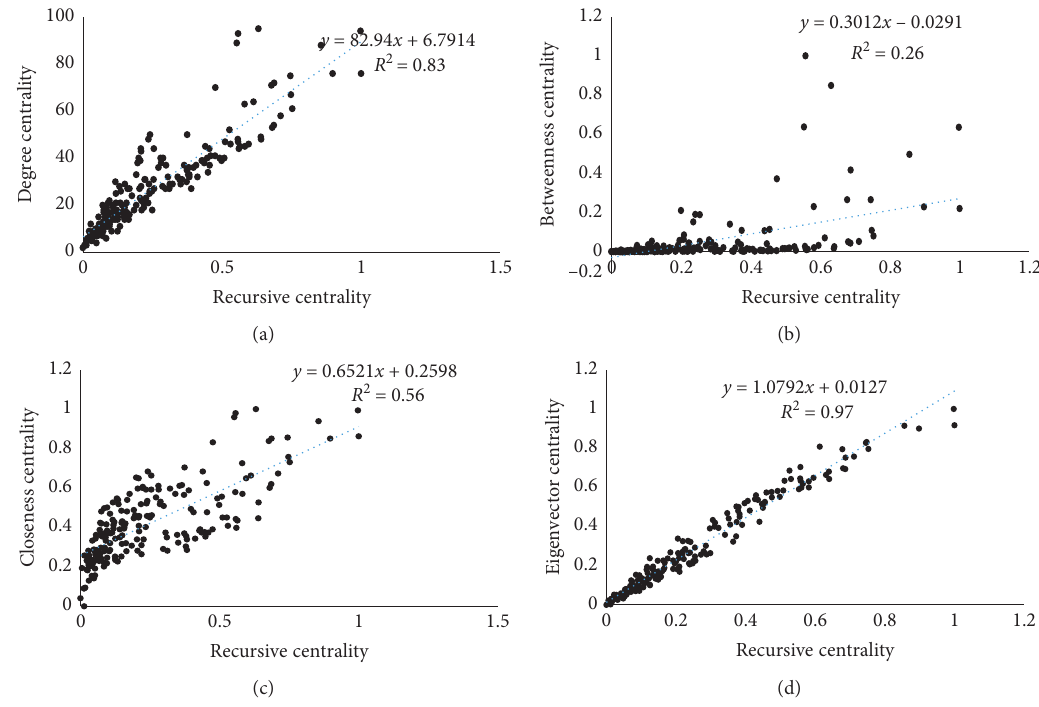
Figure 4: Correlation between recursive centrality and four other measures of centrality: (a) degree centrality, (b) betweenness centrality, (c) closeness centrality, and (d) eigenvector centrality.